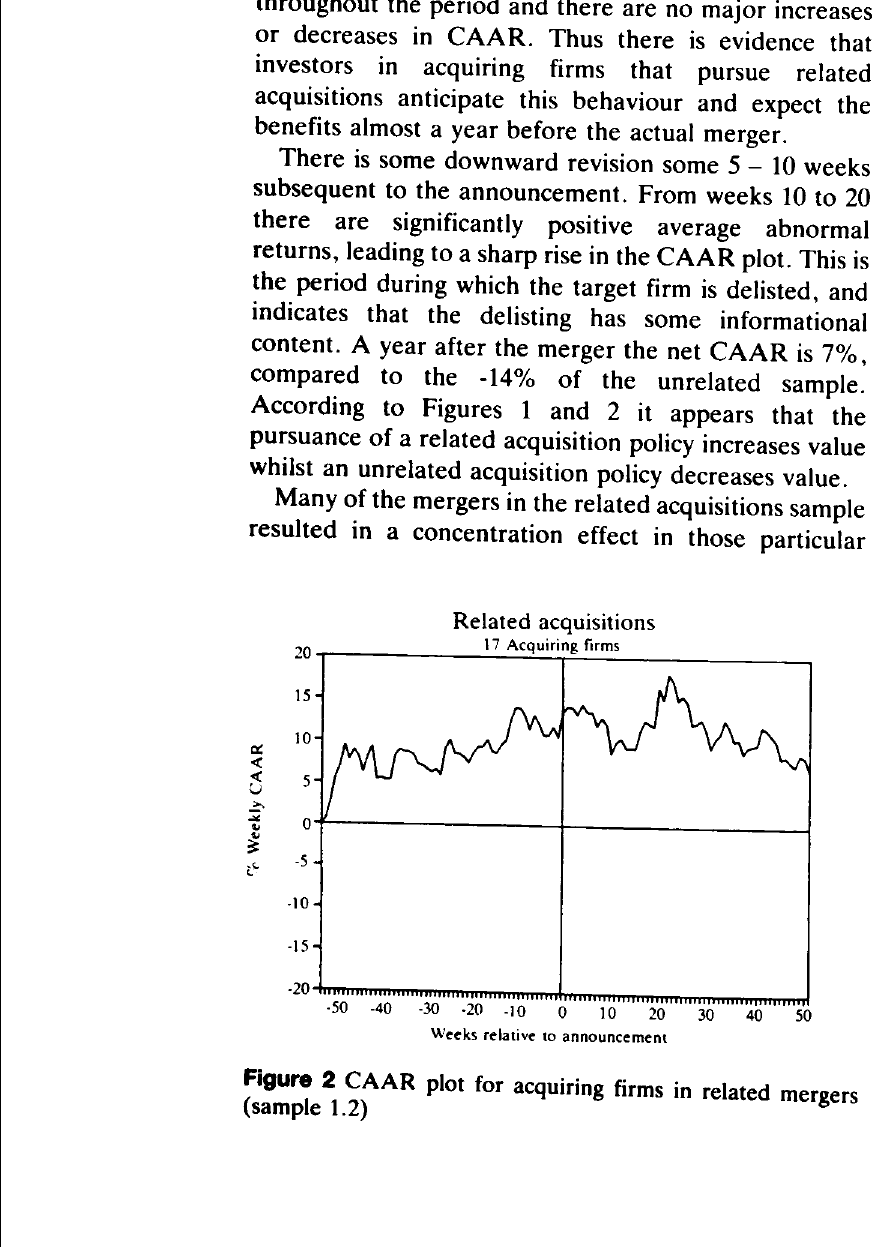
Figure 3 CAAR plot for target firms in related mergers (sample 1.2)